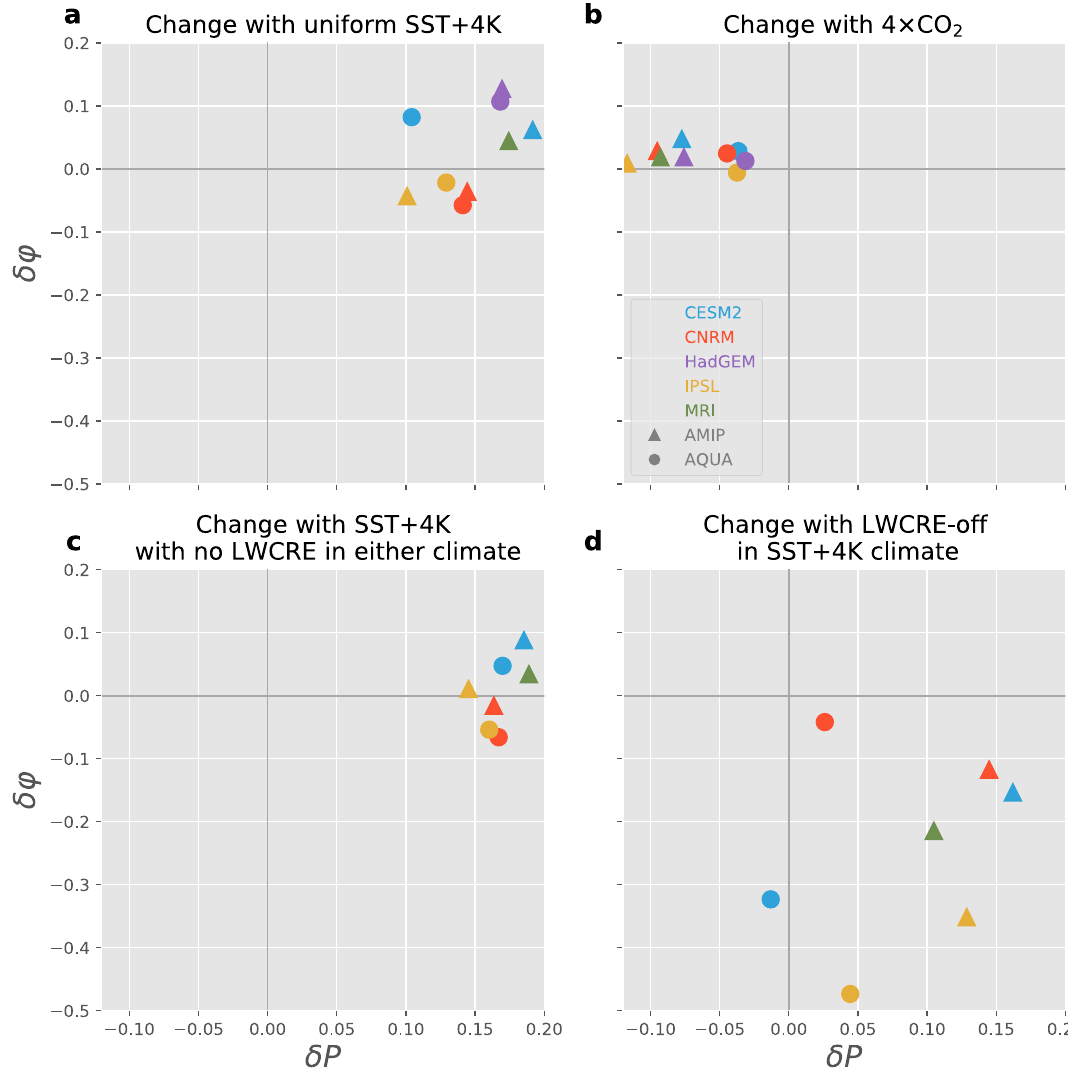
Fig. 4 Fractional changes in extreme precipitation fraction ( δ φ ) and tropical ocean mean precipitation ( δ P ) for additional experiments. As in Fig. 3 but for a changes with uniform 4K SST warming ( amip-p4K minus amip ), b the response to a quadrupling of atmospheric CO 2 with unchanged prescribed-SST ( amip-4 × CO 2 minus amip ), c changes with uniform warming between the LWoff simulations ( amip-p4K-lwoff minus amip-lwoff ), and d changes when LWCRE is removed in a warmer climate (i.e., as in Fig. 3, but with a warmer reference climate, amip-p4K-lwoff minus amip-p4K ). Italics denote CMIP experiment names, using the AMIP names (aquaplanets follow a similar